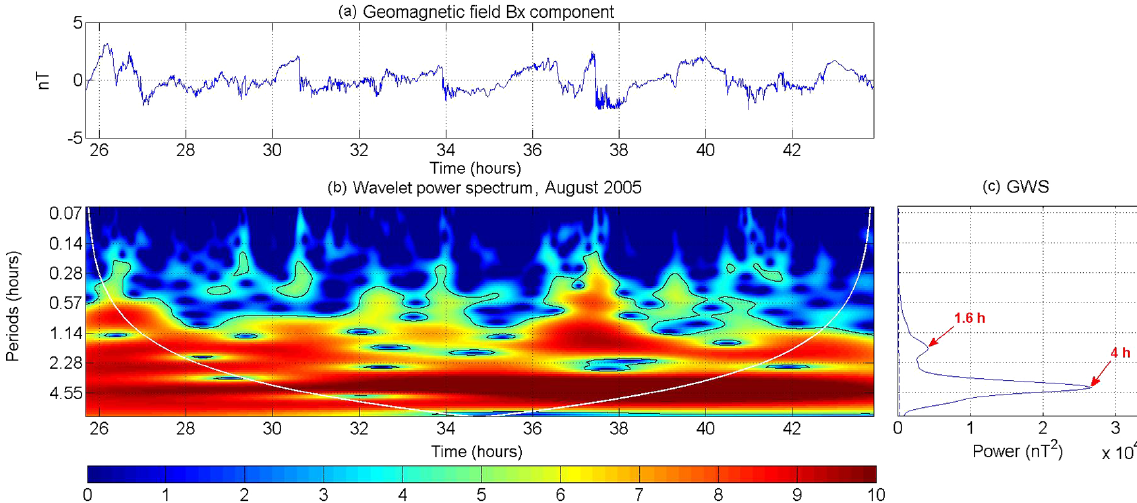
Figure 4. (a) Filtered geomagnetic magnetotail field B x component time series for the interval that the Cluster remained in the magnetotail during the HILDCCA event that occurred between 22:19UT on 5 August and 22:54UT on 7 August 2005. (b) Wavelet power spectrum. (c) GWS. In (a) and (b) , the x axes represent the number of hours after the HILDCAA event started.